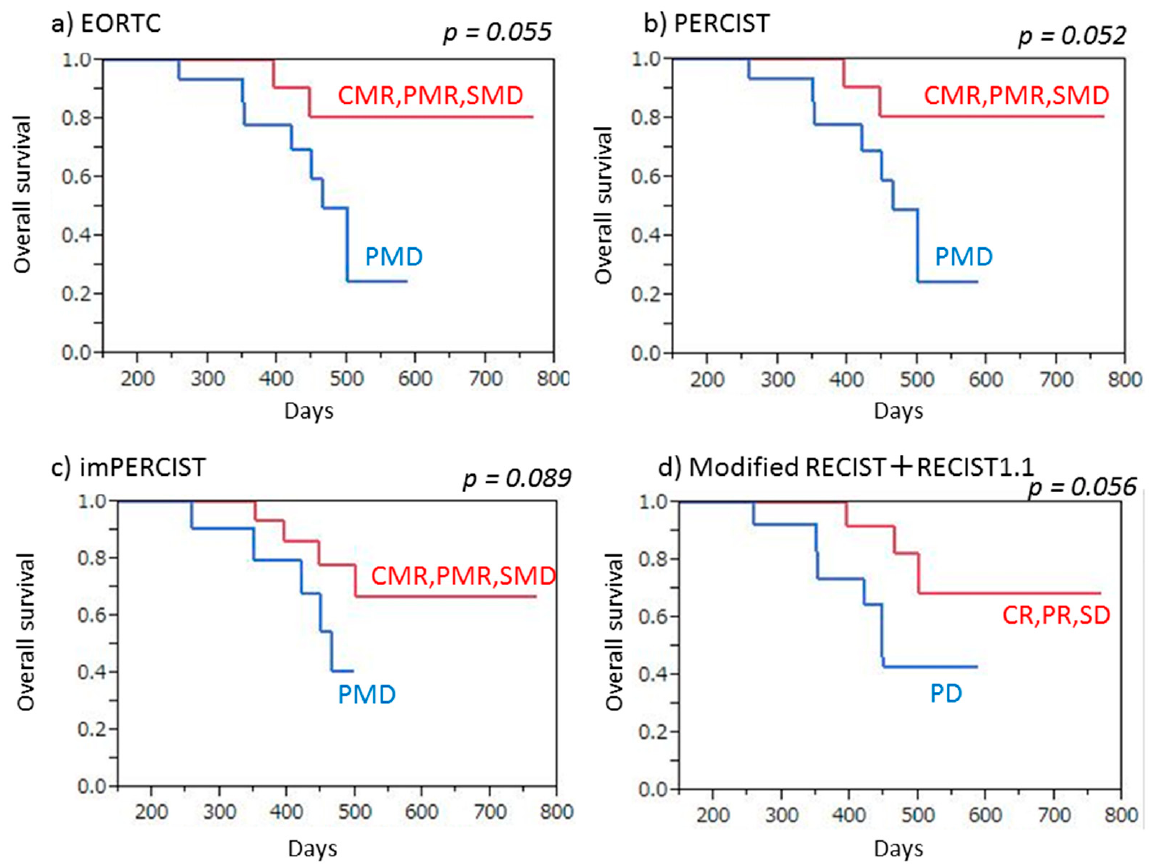
Figure 5. Overall survival (OS) of malignant pleural mesothelioma patients treated by nivolumab therapy, with and without progression. ( a ) EORTC demonstrated that patients with no progression (CMR/PMR/SMD) tended to show longer OS than those with PMD, without a significant difference ( p = 0.055). ( b ) PERCIST demonstrated that patients with no progression (CMR/PMR/SMD) tended to show longer OS than those with PMD, without a significant difference ( p = 0.052). ( c ) imPERCIST demonstrated that patients with no progression (CMR/PMR/SMD) tended to show longer OS than those with PMD, without a significant difference ( p = 0.089). ( d ) Combined modified RECIST and RECIST 1.1 demonstrated that patients with no progression (CR/PR/SD) tended to show longer OS than those without PD, without a significant difference ( p =